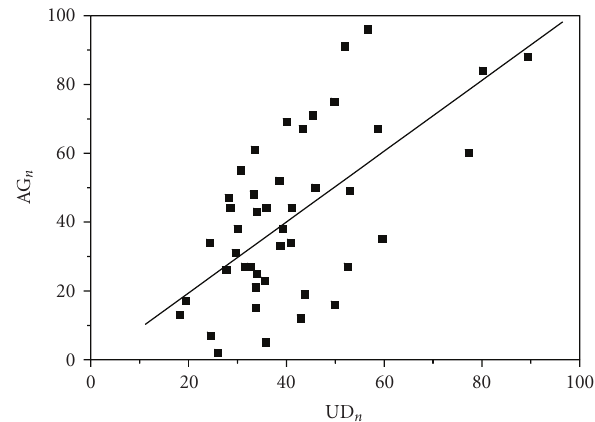
Figure 2: Linear correlation tested through the Pearson’s coe ffi cient between the number of Abrams-Gri ffi ths (BOOI: y axis) and the urethral device number (UD n : x axis), r = 0 . 653, P < . 0001.